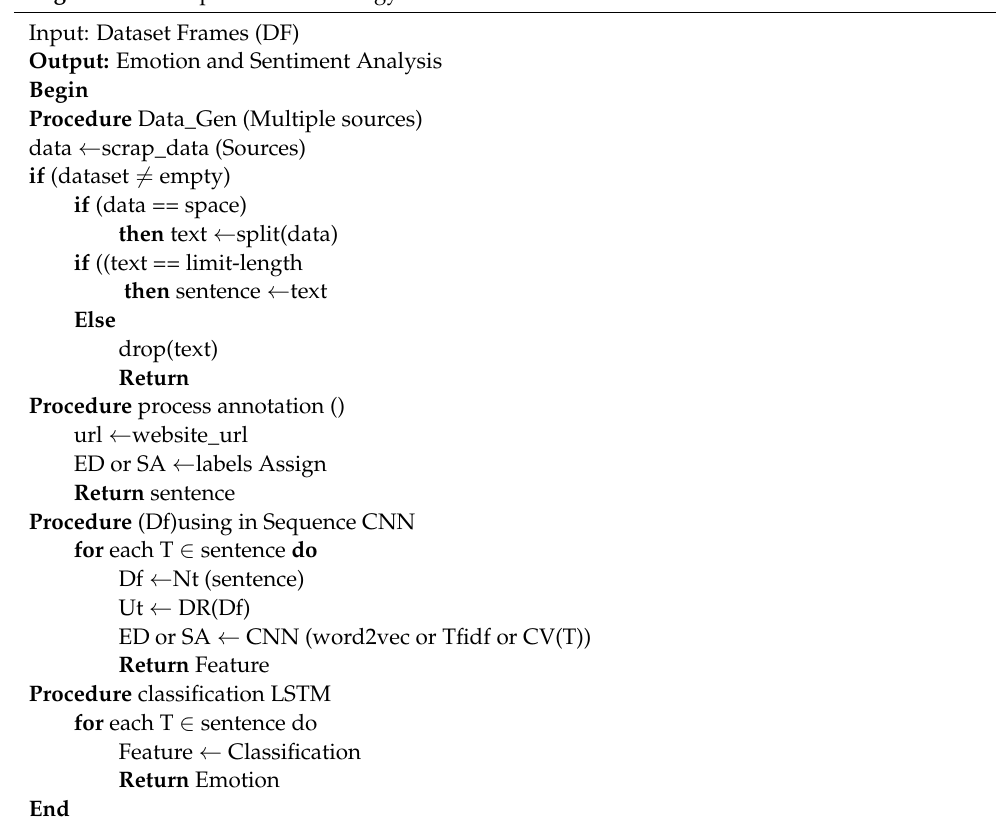
Algorithm 1: Proposed